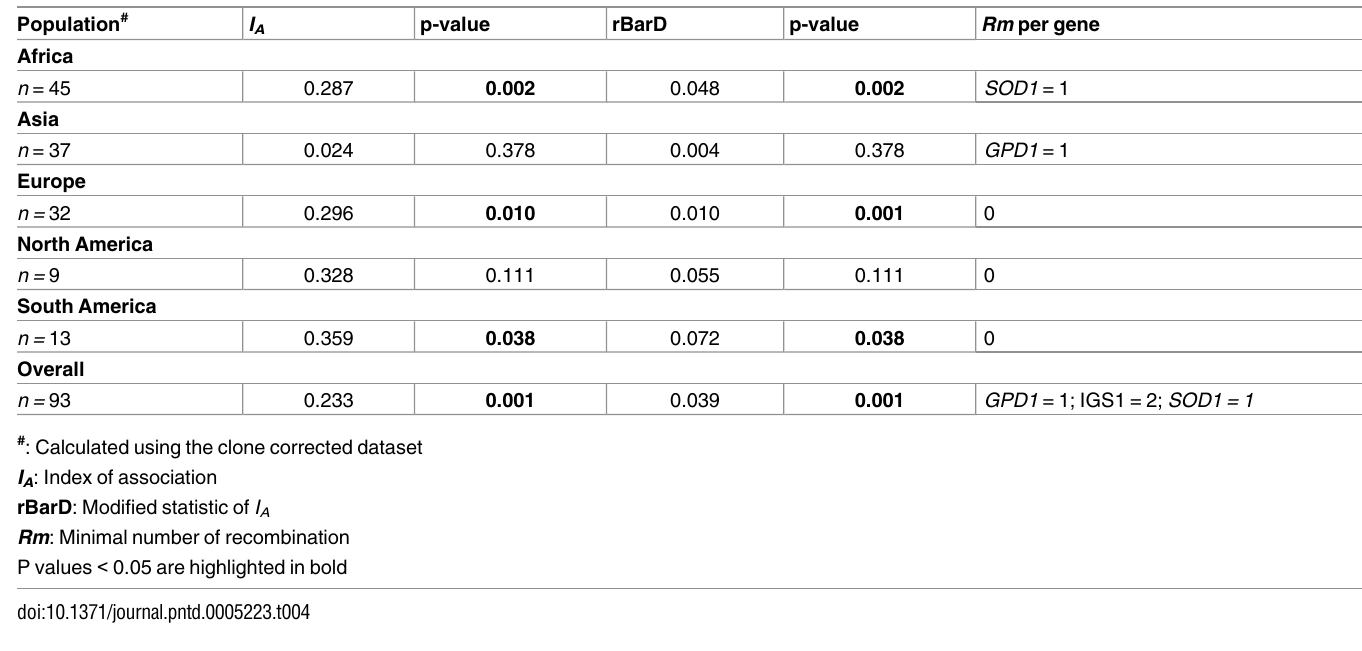
Table 4. Multilocus linkage disequilibrium and recombination analyses amongst Cryptococcus neoformans var. grubii VNI continental